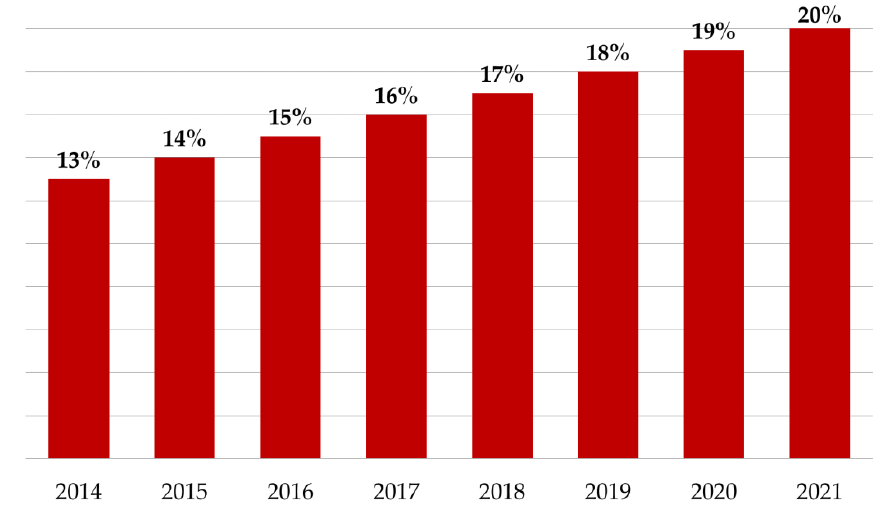
Figure 4. The yearly targets of renewable electricity generation in Poland.